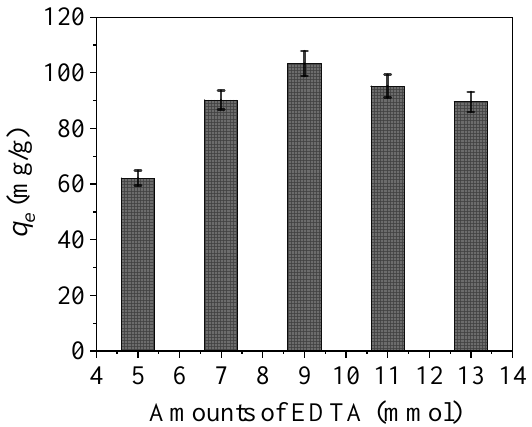
Figure 9. Effect of EDTA addition on ( C 0 = 20mg/L, pH = 7, dosage = 0.01 g, t = 6 h and T = 298 K).